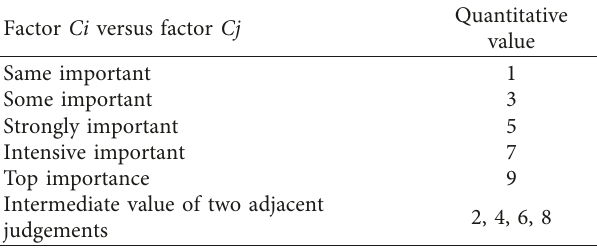
Table 2: 1–9 Proportional scaling